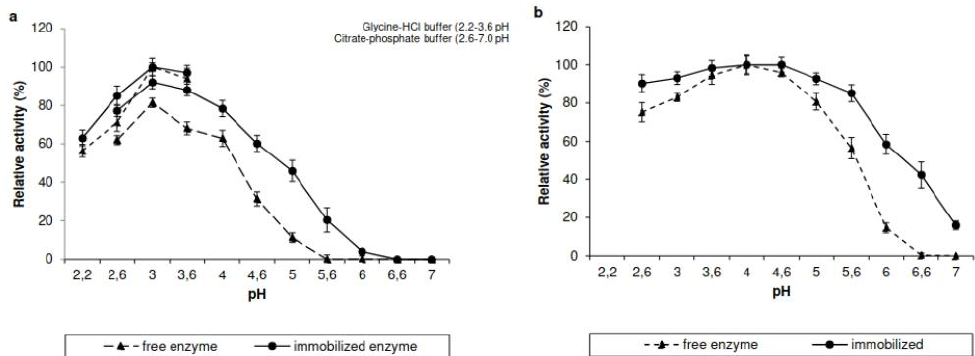
Figure 8. Optimal pH and pH stability of Tt LacA. Optimal pH and stability profile at different pH values for free ( ▲ , dotted line) and immobilized (●, con tinuous line) Tt LacA in copper alginate gel beads. ( a ) The optimal pH was determined using two buffers (100 mM): glycine-HCl buffer (pH 2.2 – 3.6) and citrate-phosphate (pH 3.6 – 7.0). ( b ) the stability pH was determined using citrate-phosphate buffer (pH 2.6 – 7.0) at 25 °C for 50 min.